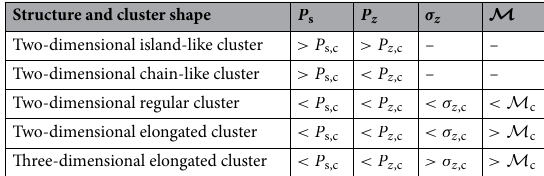
Table 1. Parameter values used to classify cluster types are P s,c = 100 , P z ,c = 0.65 , σ z ,c = 0.25 , and M c = 0.8 .